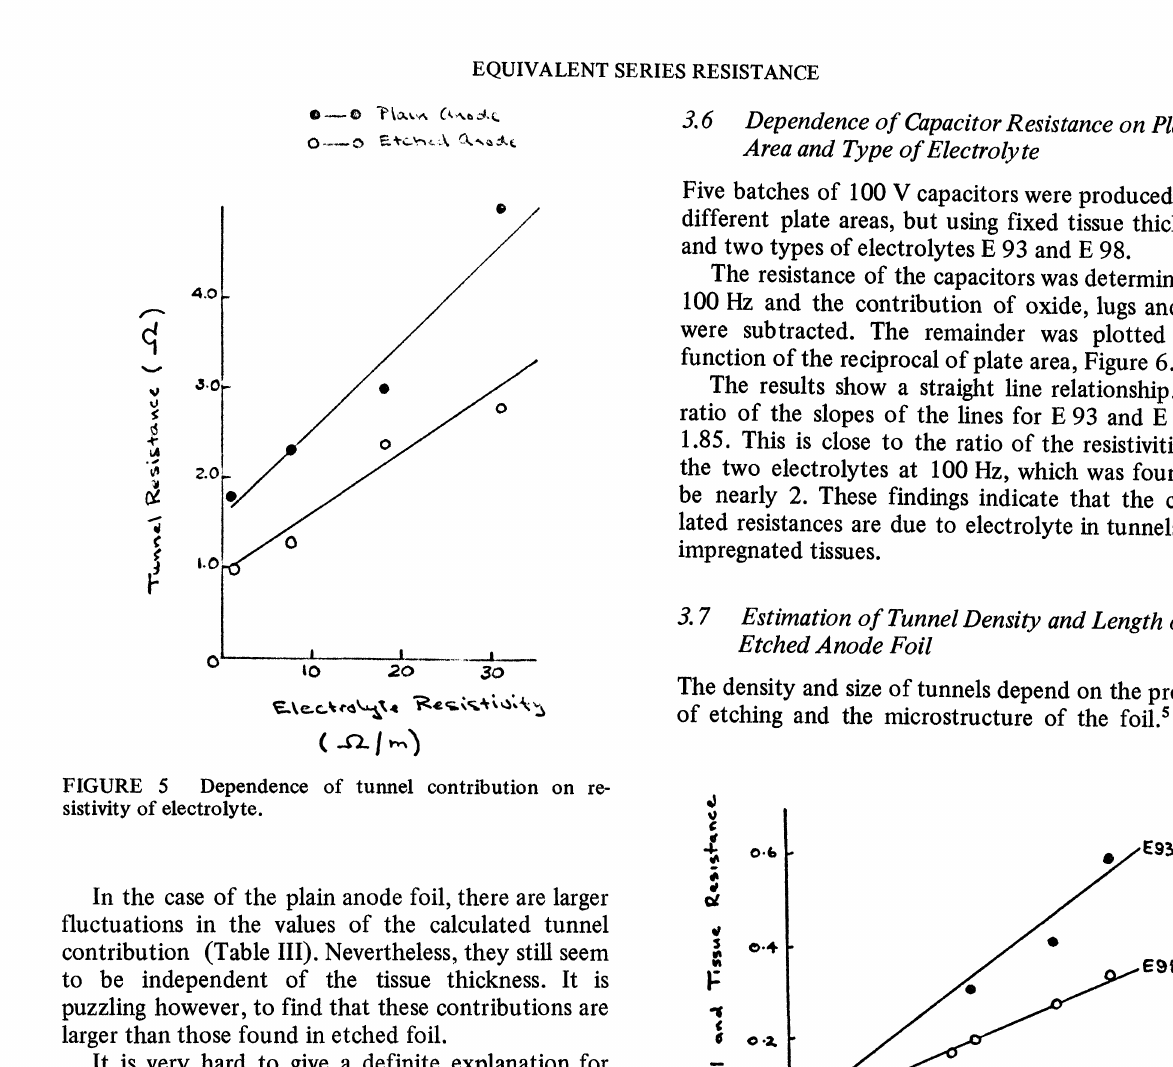
Dependence of tunnel and tissue resistance on the reciprocal of plate area.